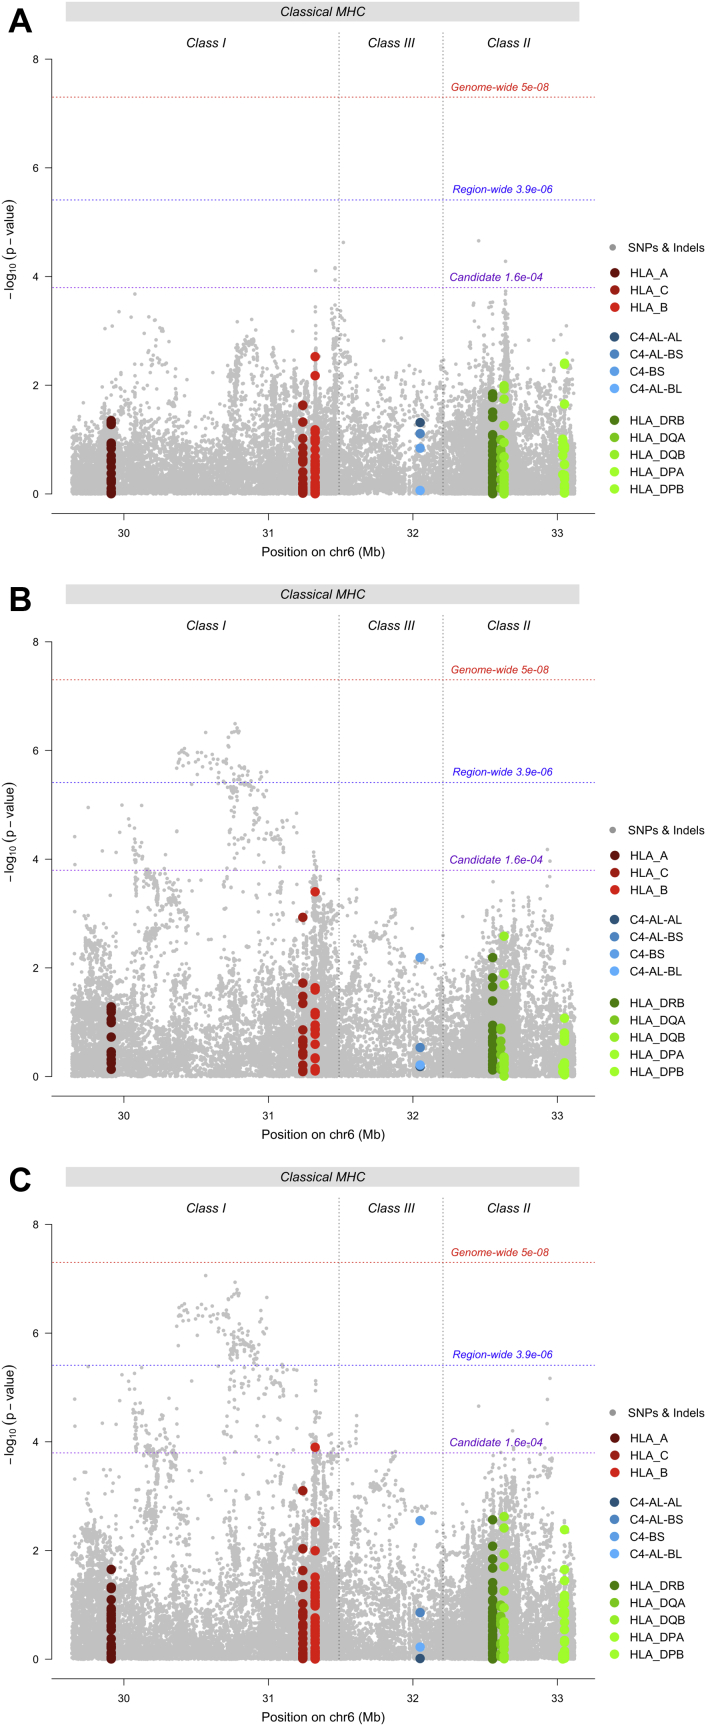
Region-wide Manhattan plots for single nucleotide polymorphisms (SNPs) (gray), human leukocyte antigen (HLA) alleles (HLA-A, HLA-B, and HLA-C [red] and HLA-DPA, HLA-DPB, HLA-DQA, HLA-DQB, and HLA-DRB [green]), and complement component 4 (C4) haplotypes (C4-AL-AL, C4-AL-BS, C4-BS, and C4-AL-BL [blue], where A and B represent the isotype of the C4 gene, L indicates the long form, and S indicates the short form) in (A) Major Depressive Disorder Working Group of the Psychiatric Genomics Consortium (PGC-MDD) studies, (B) UK Biobank sample, and (C) meta-analysis of PGC-MDD studies and UK Biobank sample. chr, chromosome; Indels, insertions and deletions; MHC, major histocompatibility complex.